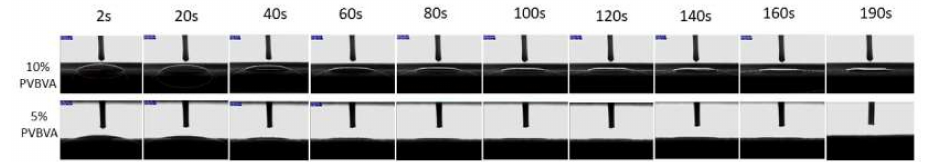
Figure 4. Evolution of PVBVA droplets’ profiles associated with the solution up-take process for 5% PVBVA (bottom) and for 10% PVBVA (top) solutions.